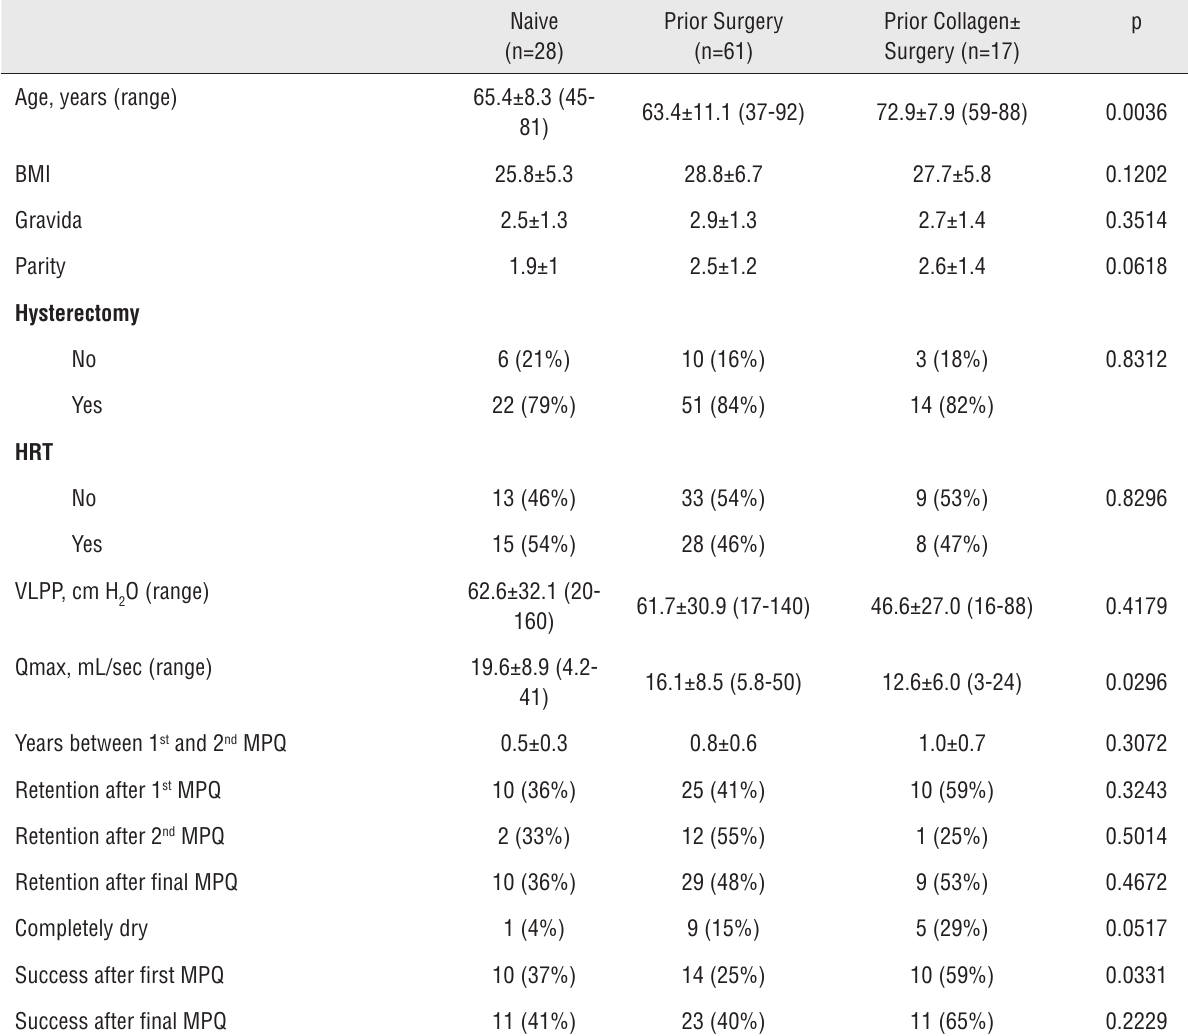
Table 1 - Patient characteristics by prior incontinence treatment